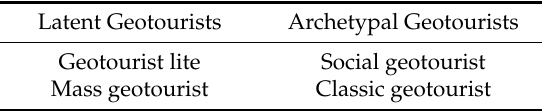
Table 2. Conceptual geotourist